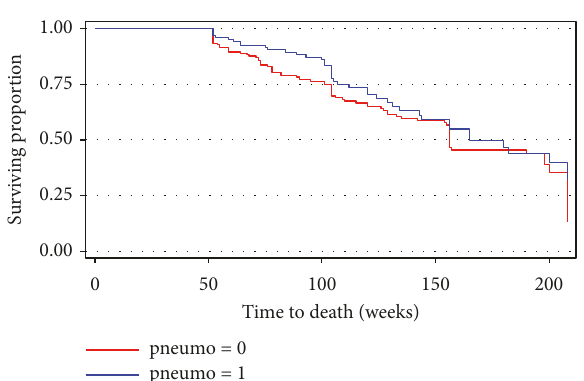
Figure 2: Kaplan-Meier curve showing surviving proportion of the children with pneumonia (pneumonia = 1) and children without pneumonia (pneumonia = 0).